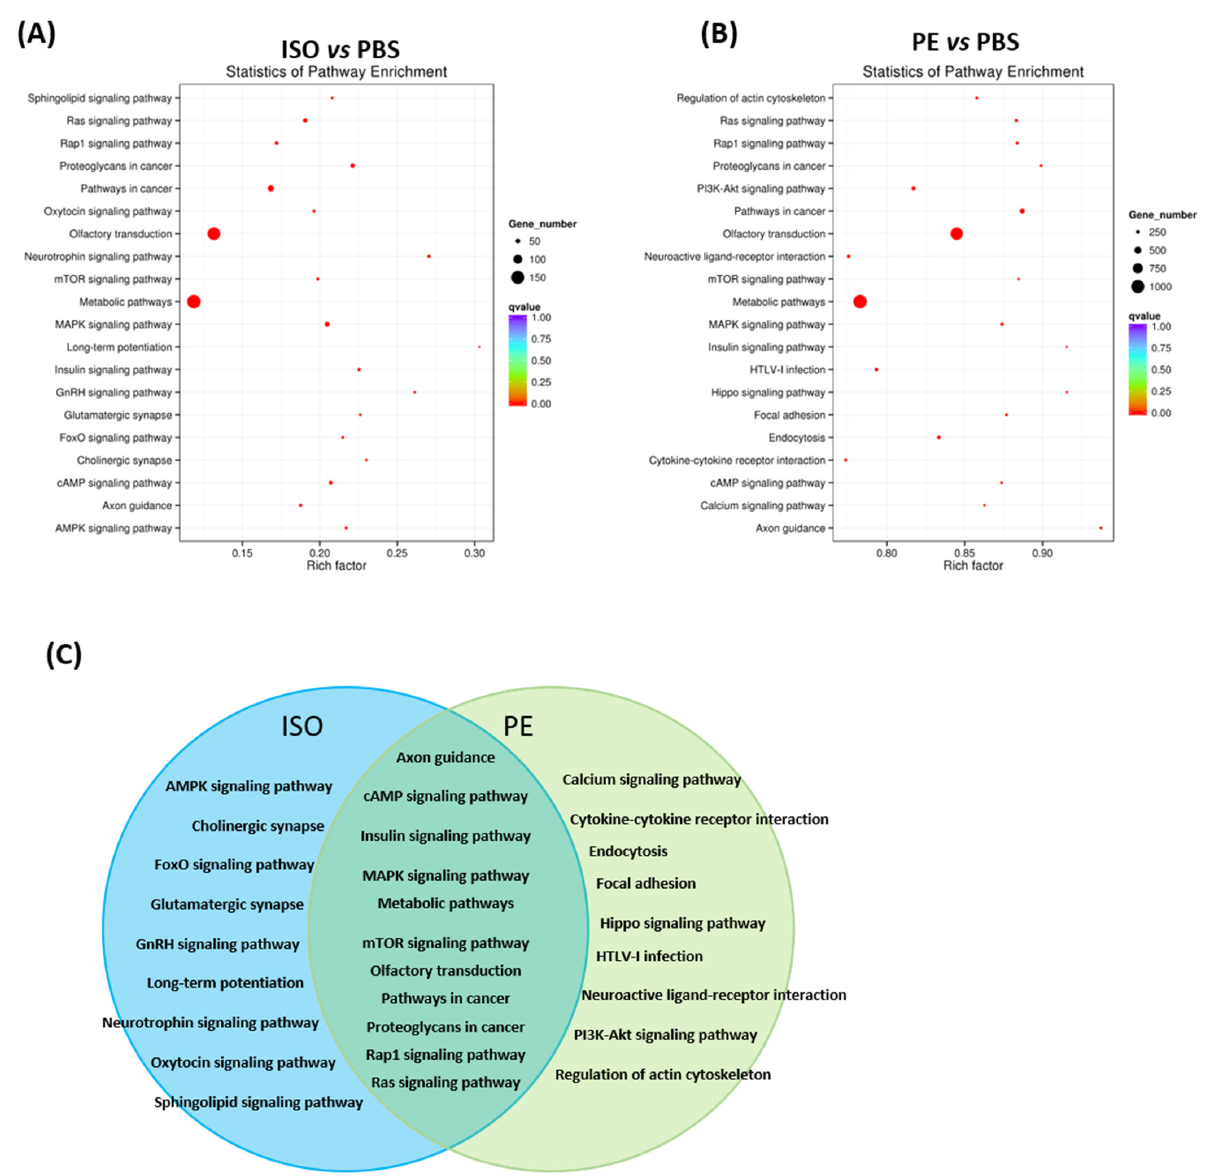
Figure 4. Differentially expressed miRNAs target mRNA genes in enriched KEGG pathway: ( A , B ) Scatter plot KEGG pathway enrichment statics; ( A ) ISO versus PBS; ( B ) PE versus PBS; ( C ) Venn diagrams showed 11 overlap pathways and 9 different pathways detected in ISO and PE blood EVs. PBS ( n = 3), ISO ( n = 3, 10 mg/kg/day) and PE ( n = 3, 30 mg/kg/day) infusion for 1 week.